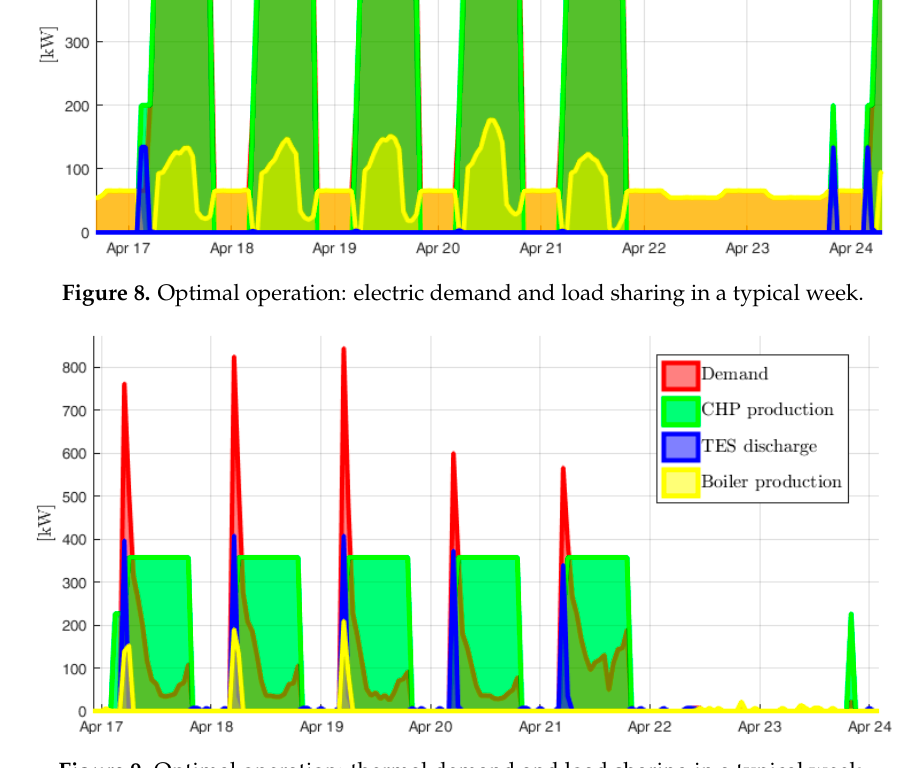
Figure 9. Optimal operation: thermal demand and load sharing in a typical week.